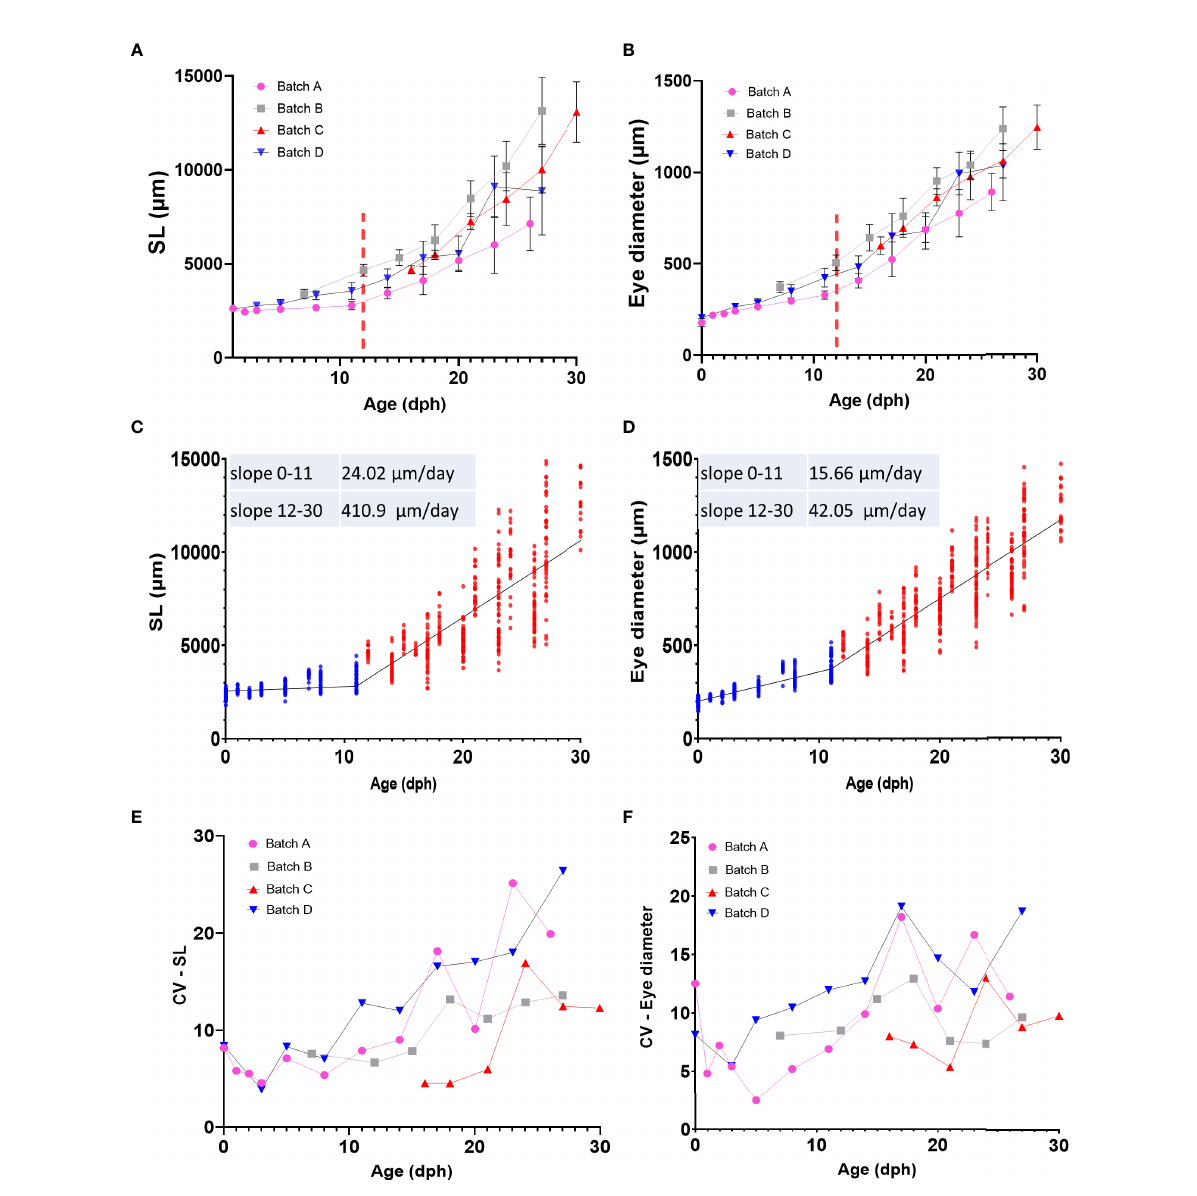
FIGURE 3 Growth pattern of grey mullet larvae (A) Age-standard length (SL) relationship (B) Age-Eye diameter (ED) relationship. In A and B, each batch is represented by a different color, Red dashed bar marks approximate onset of metamorphosis. (C, D) Linear regression of standard length (C) and eye diameter (D) by age. Both parameters show a biphasic growth pattern. Blue dots represent individual fi sh from 0 to 11 dph. Red dots represent individual fi sh from 12 to 30 dph. (E, F) Changes in variance (CV) of SL (E) and ED (F) in relationship to age in each of the sampling